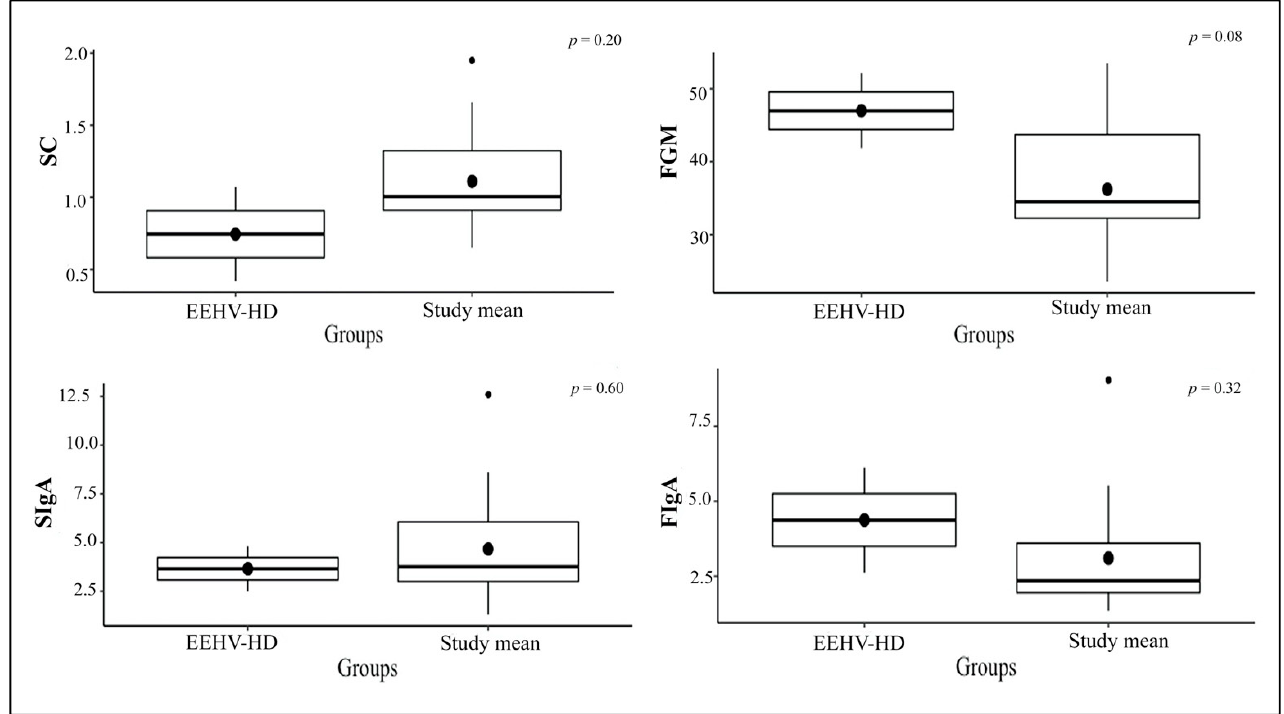
Figure 5. Boxplot presented concentrations of salivary cortisol (SC), fecal glucocorticoid metabolites (FGM), salivary IgA (SIgA), and fecal IgA (FIgA) categorized by EEHV status (non-EEHV or prior-EEHV), excluding E5 that developed EEHV-HD and died during the study.